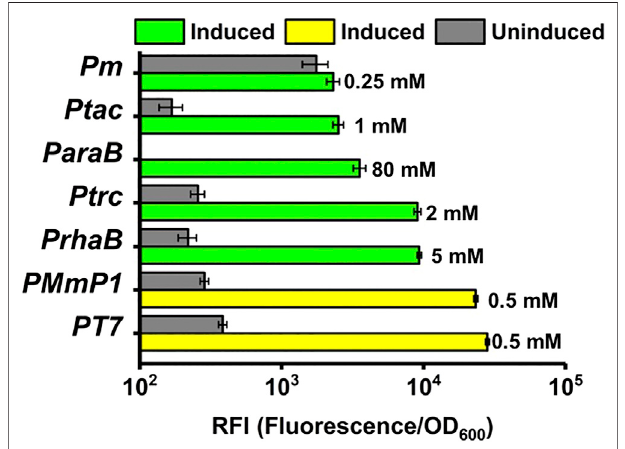
FIGURE7| Theactivity ofNDHaseintheMmP1expression systemwith the integration site ofPP_5003comparedwith theplasmidexpression both in P. putida KT2440 and P. putida